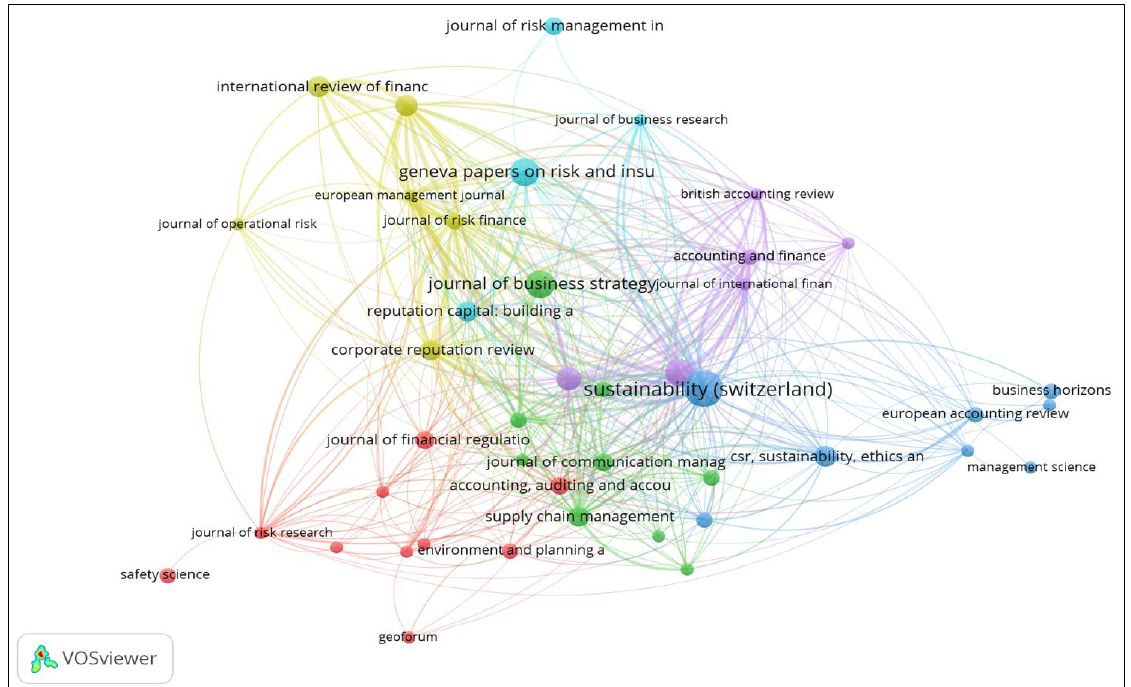
Figure 4. Sources of published reputation risk papers map